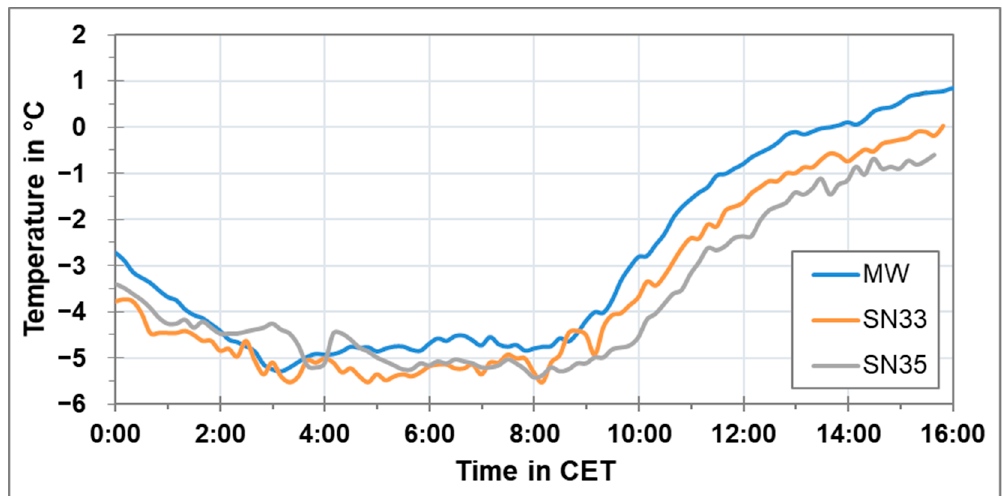
Figure 15. Air temperature at three stationary locations along the route of the rack railway on 22 February 2019 from 00:00 CET until 16:00 CET.